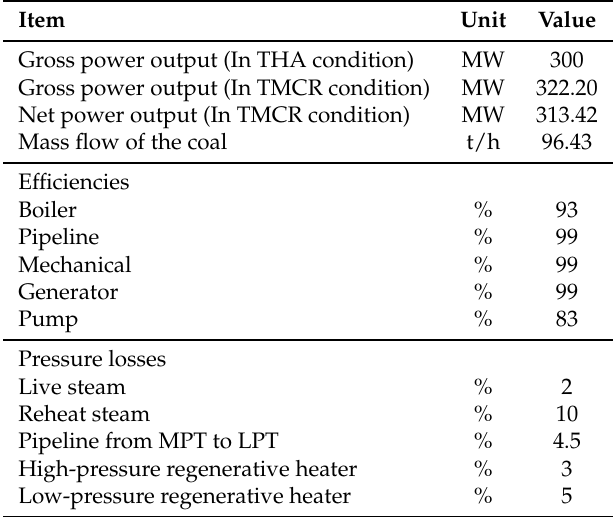
Table 1. Main technical parameters of the reference power plant.